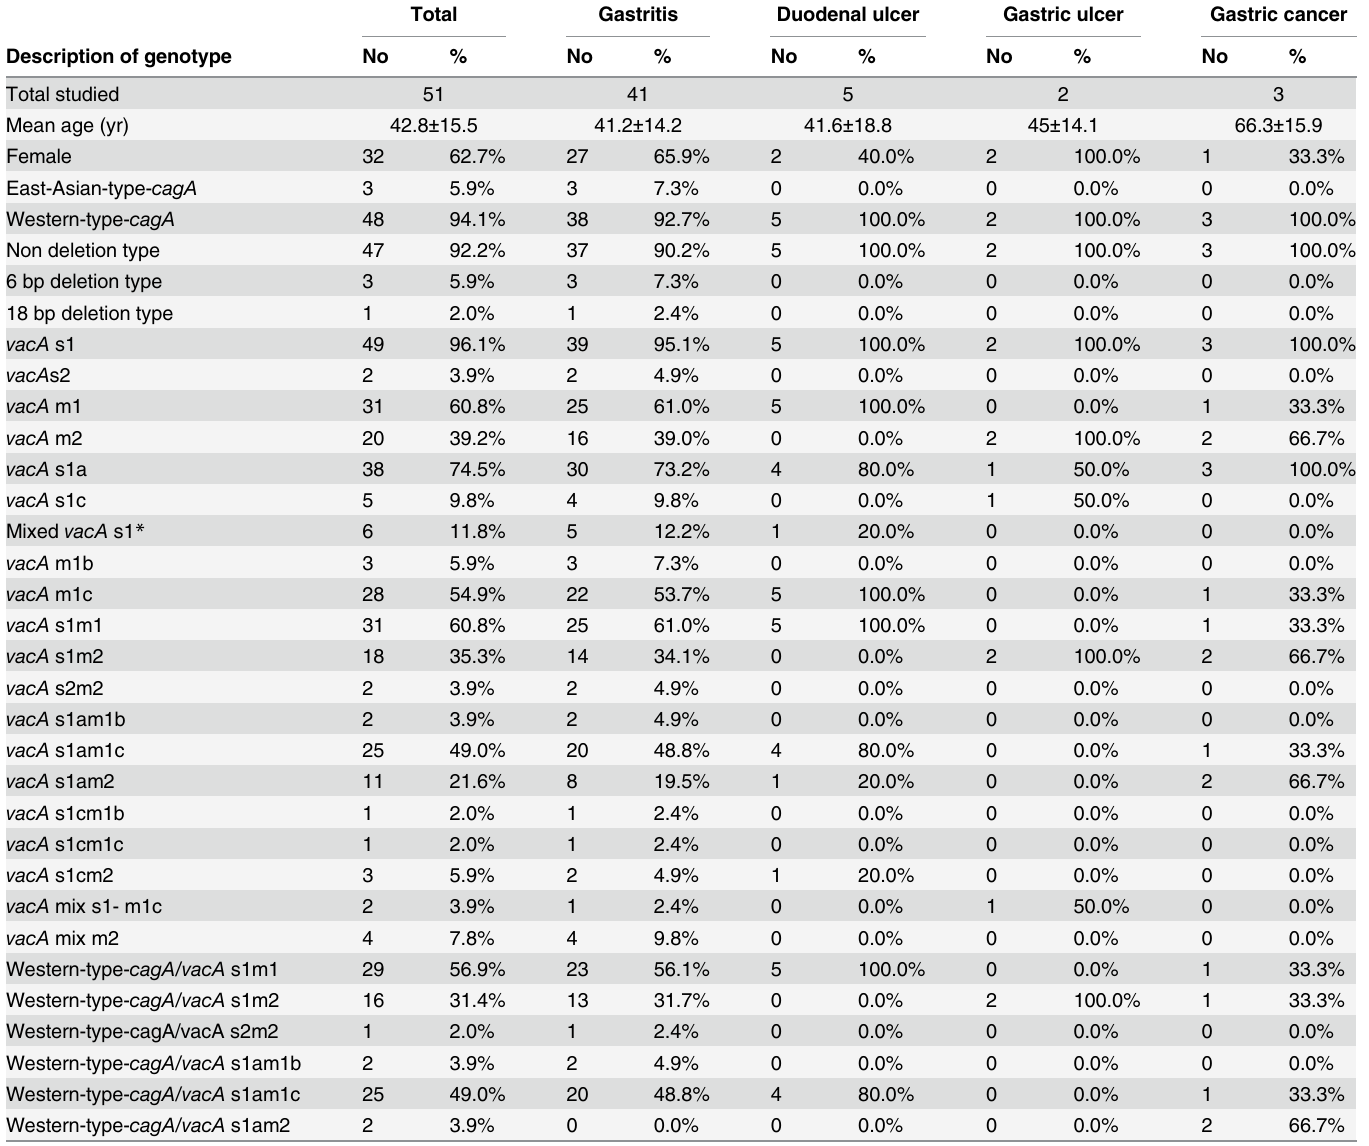
Table 3. Association between H . pylori virulence factors and clinical